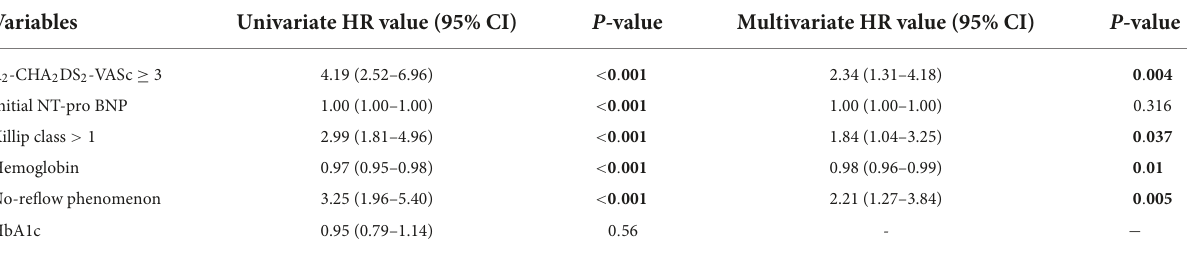
TABLE 4 Univariate and multivariate cox regression of long-term MACE.